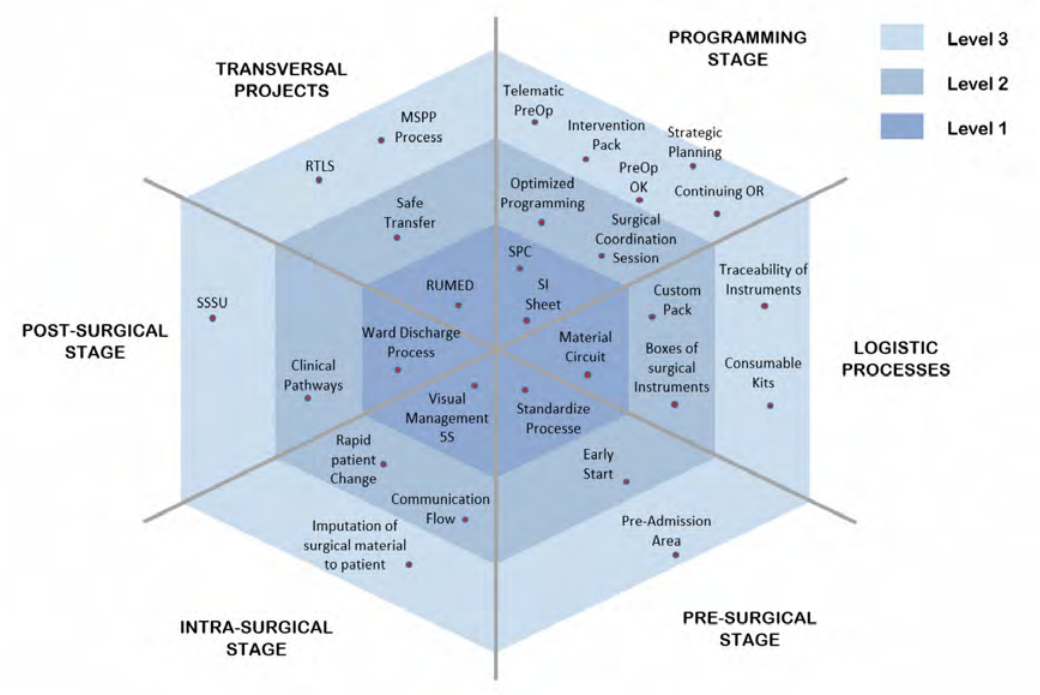
Figure 2. Surgical Process Projects by Levels and